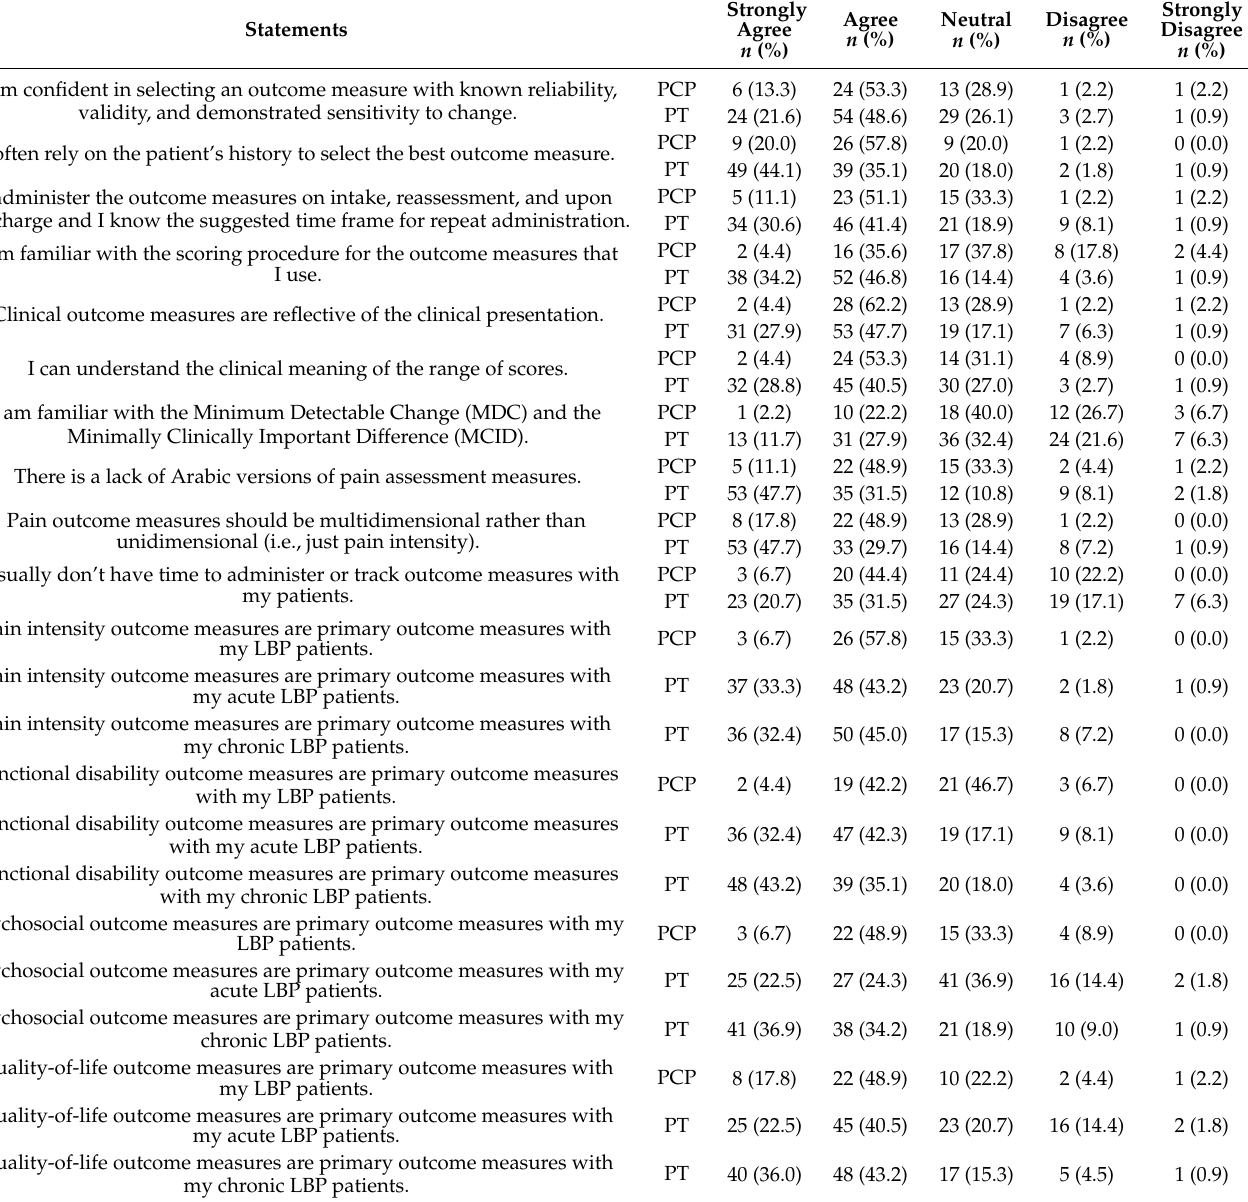
Table 3. Attitudes, knowledge, and beliefs about the use of patient-reported outcome